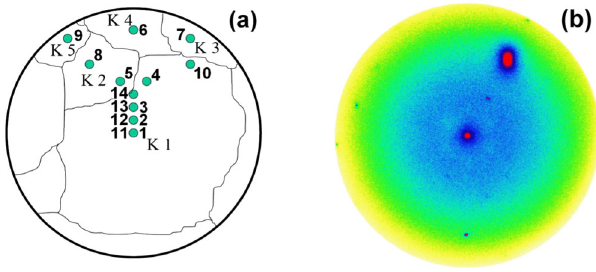
measurement locations. (b) X-ray reflexes on the central crystal of the W. C. HERAEUS disk.